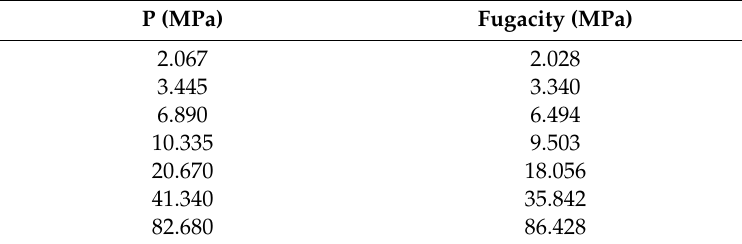
Table 2. Fugacity data used in the adsorption calculations.